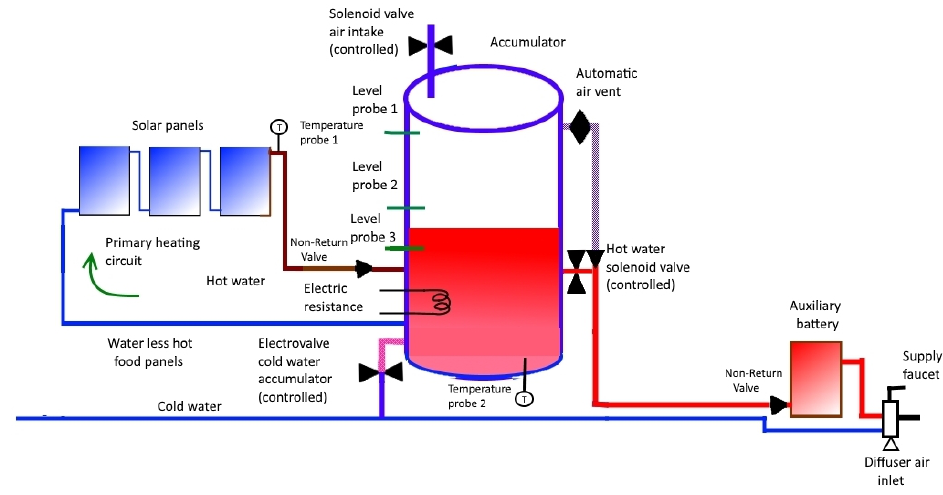
Figure 3. Functioning scheme 2.